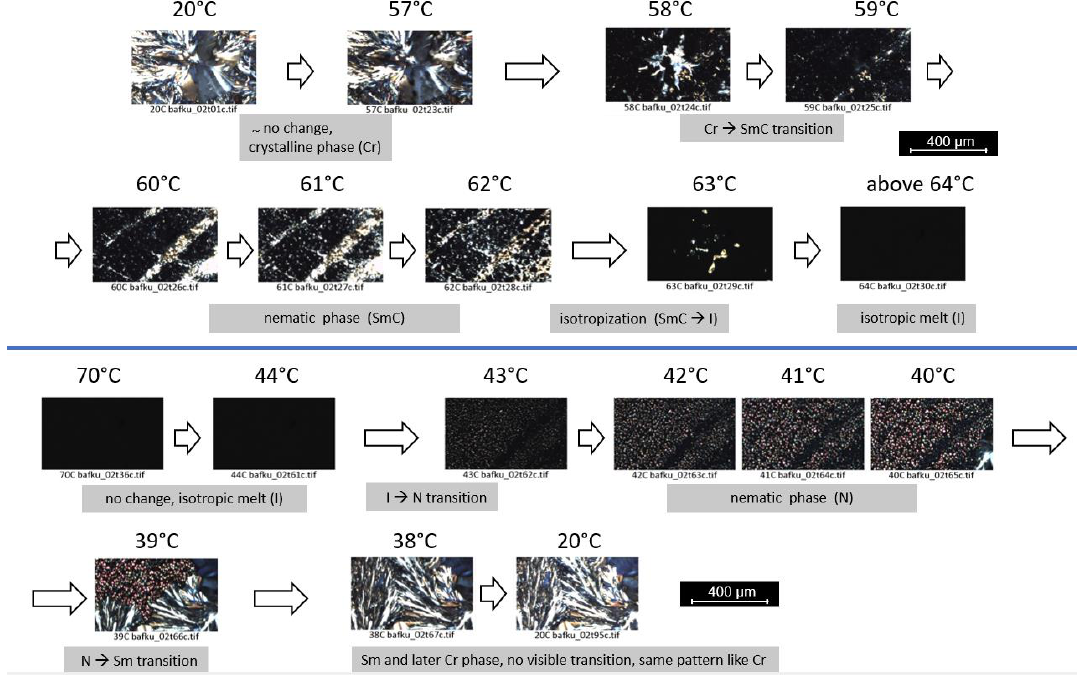
Figure 5. Textures observed in neat BAFKU mesogen. Top: heating run; bottom: cooling run; large representative images of each characteristic texture are shown in the Supplementary Materials, SI Figures S20 and S21.